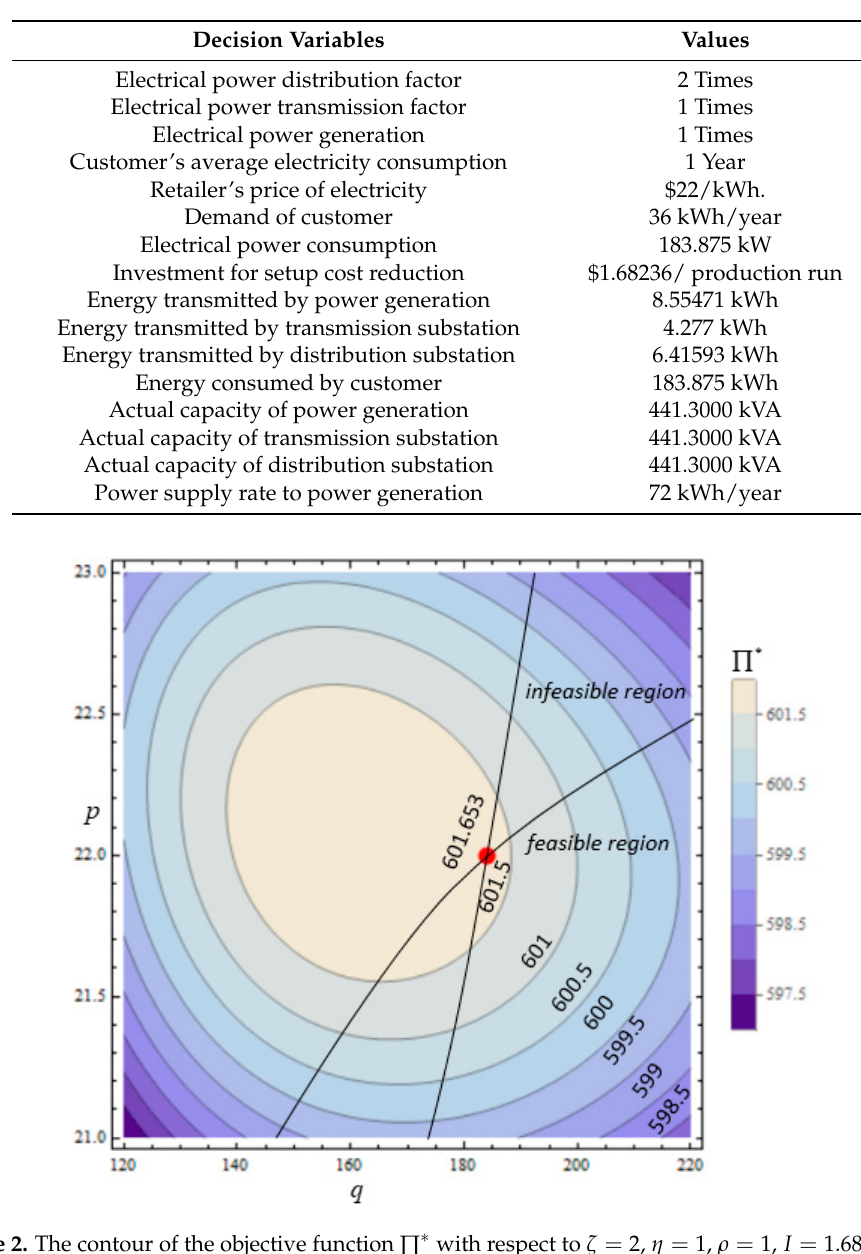
Figure 3. Concavity of